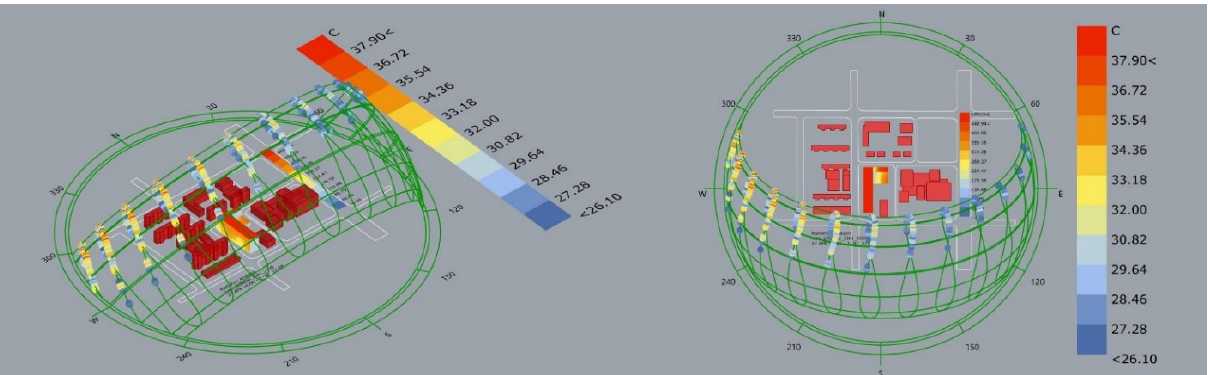
Figure 6. The solar trajectory and solar position on high-temperature days in Xi’an (temperatures exceeding 26 °C).